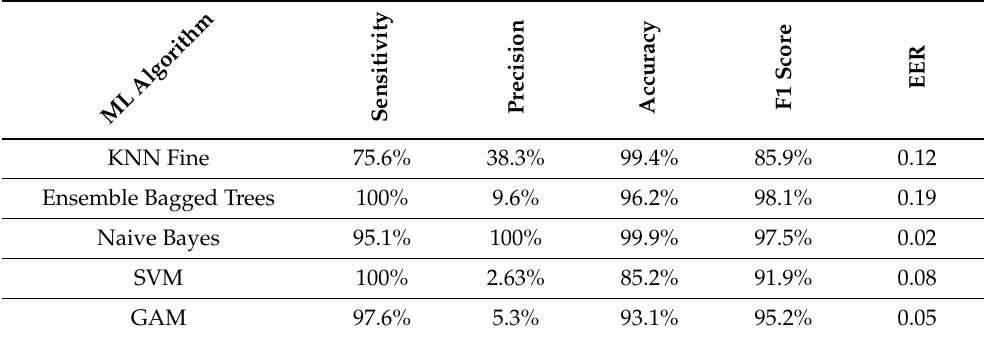
Table 4. ECG Result Details—Scalable Attack